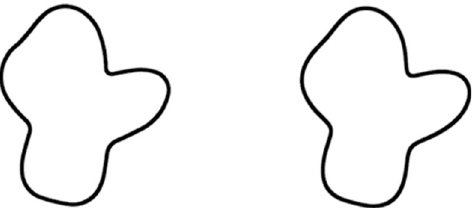
Fig 1. Example of shape abstraction. These two shapes differ in local curvatures at every point but are perceptually identical or very similar. The figure on the right was created by approximating contour regions in the figure on the left with constant curvature segments. Despite their differing curvature values, they have 98% shape overlap (see Experiment 3 for details) and can only be distinguished by apparent motion when a display flashes between